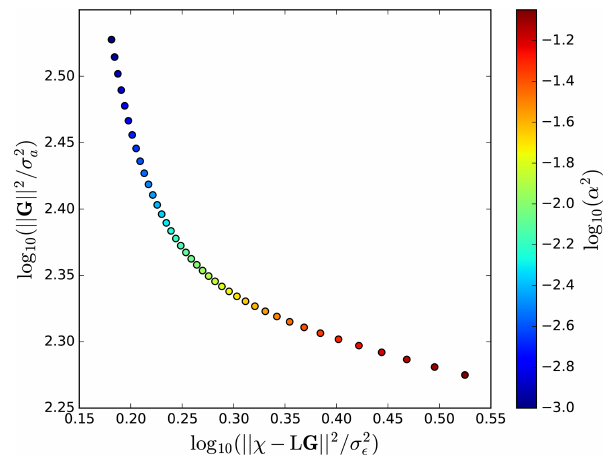
Figure 2. Average L curve for the 1-month-resolution setup. ( L G est − Each point of this curve corresponds to a pair < 1 σ 2 (cid:15) ξ obs ) T ( L G est − ξ obs ) > vs. < 1 G estT G est > with G est calcu- σ 2 a lated using Eq. (23) with the corresponding value of α , and σ (cid:15) = 0 . 029mm − 3 and σ a = 10 − 2 month − 1 . The displayed curve is the average misfit vs. the average constraint for 100 retrievals from 100 sets of pseudo-observations with different realizations of the noise (different (cid:15) in Eq.